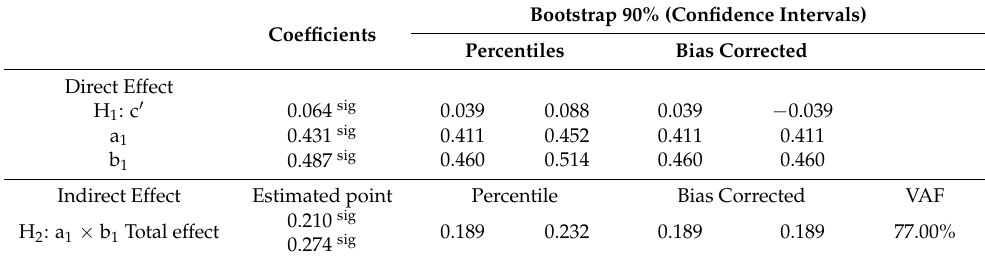
Table 8. Model Hypothesis (test mediation